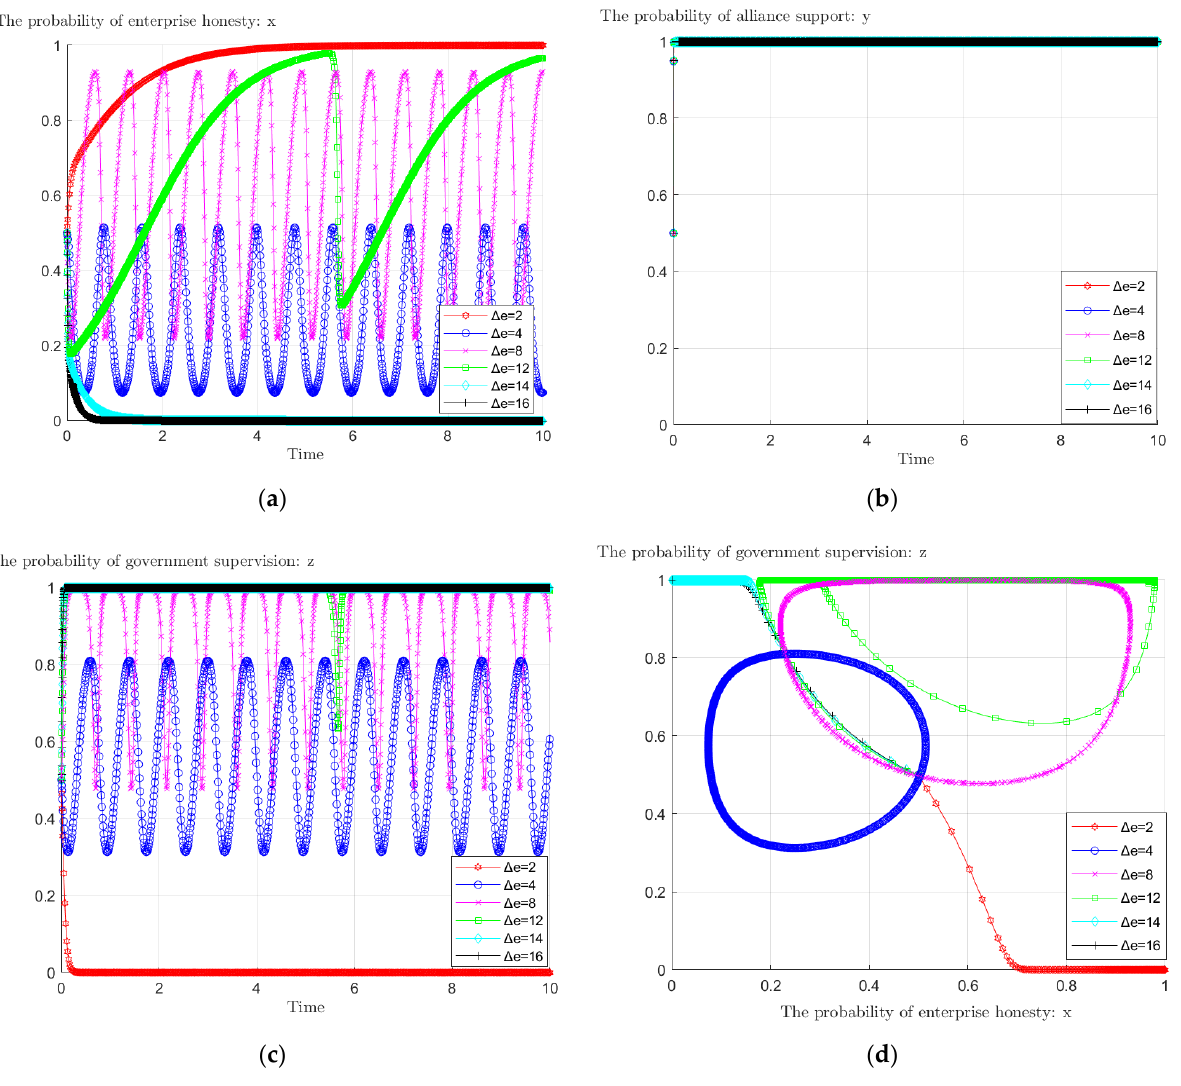
Figure 7. The impact of Δ e on: ( a ) enterprises’ behavioral evolution; ( b ) alliance’s behavioral evolu- tion; ( c ) governmental behavioral evolution; ( d ) governmental and enterprises’ behavioral evolu- tion.